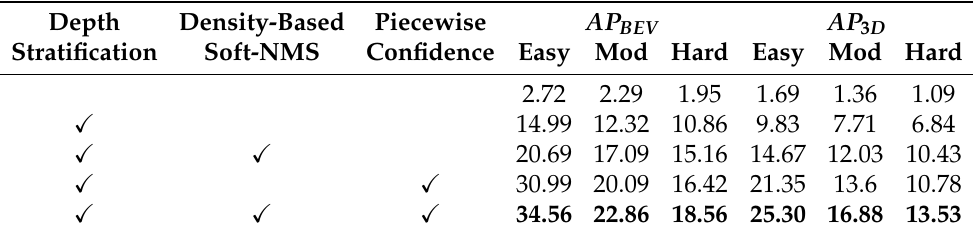
Figure 13. Qualitative results of our framework in the KITTI validation set. Table 5. The AP 40 for ablation experiments on network components. We use bold type to indicate the best